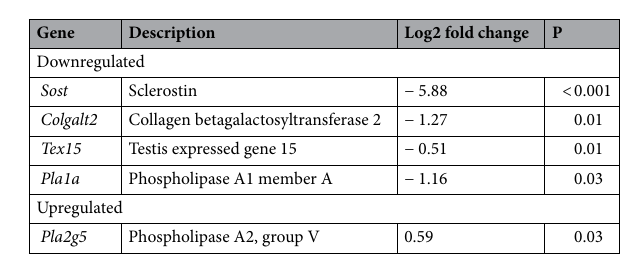
Figure 5. Cortical bone characterization. Femur midshaft microCT and biomechanics. ( A ) MicroCT images of midshaft femur scans. ( B – D ) MicroCT data for bone structure. ( E – G ) Results of three-point bending tests. Error bars represent standard errors. Significance levels for differences to WT mice (ANOVA) are indicated above each bar: *p < 0.05, **p < 0.01, ***p < 0.001, ns: not significant (p ≥ 0.05). Significance levels for differences between Jrt;Sost-het and Jrt;Sost-ko are indicated above the horizontal lines. n = 6–15 mice per group.